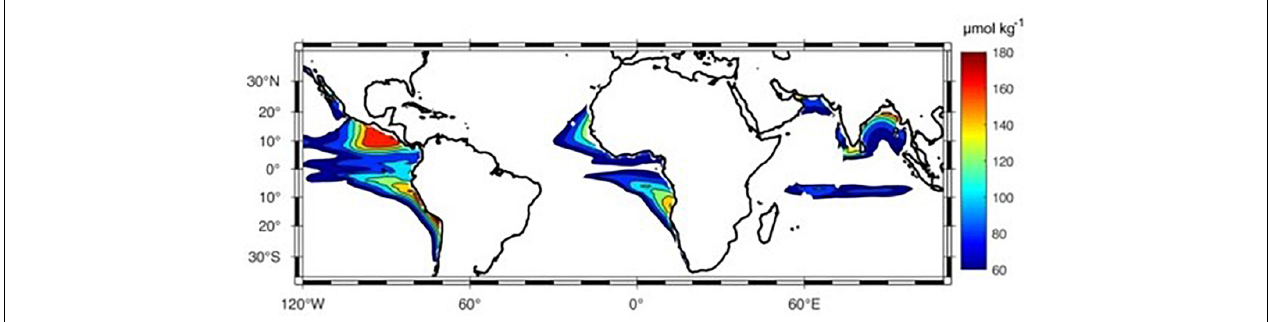
FIGURE 3 | Distribution of the oxygen difference between 70 and 10 m depth (concentrations < 60 µ mol kg − 1 have been omitted) based on an oxygen climatology. Data from Schmidtko et al.